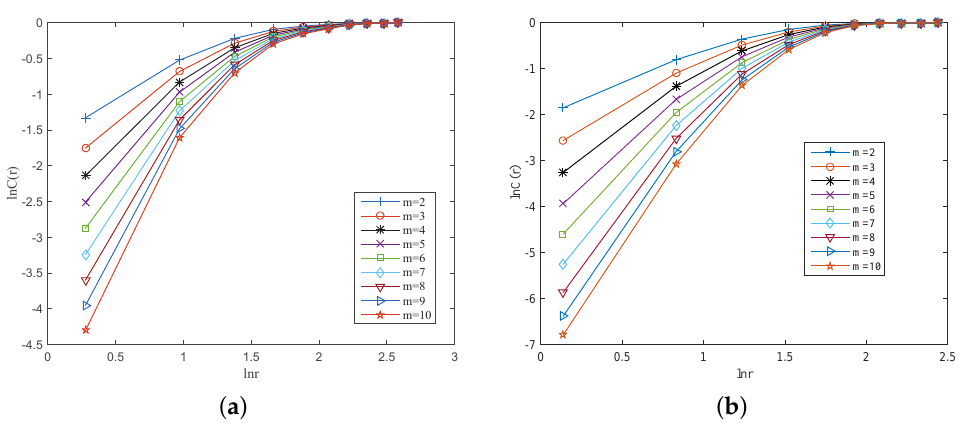
Figure 5. Double logarithmic coefficient relationship curve lnC(r)-ln(r). ( a ) A1; ( b ) A10.